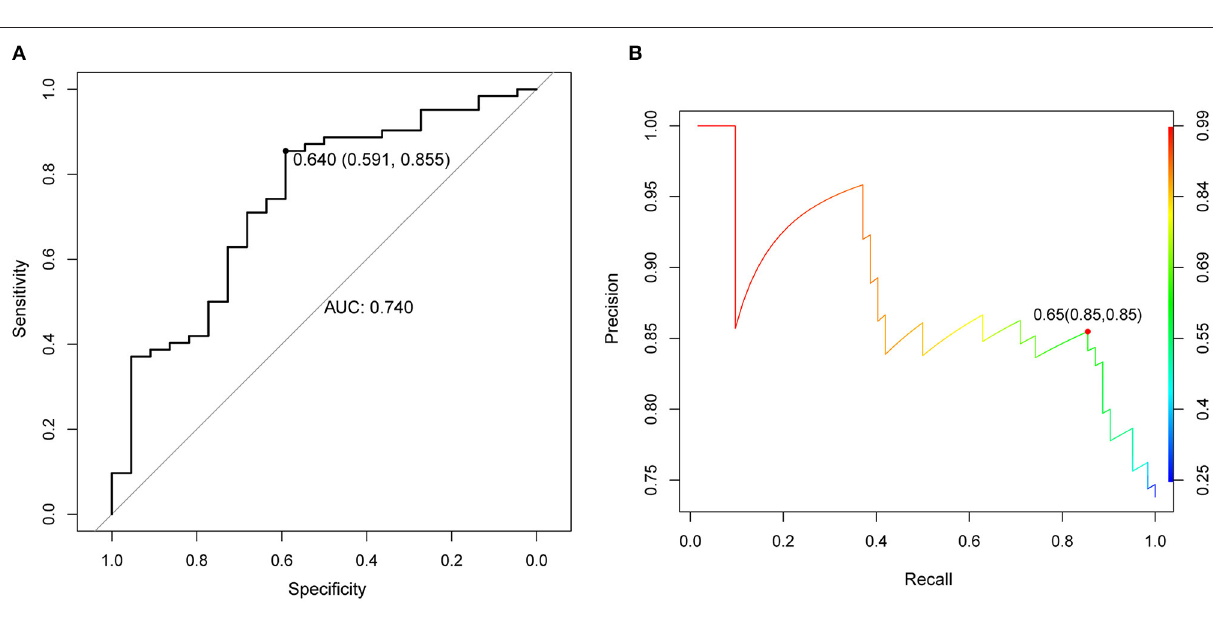
FIGURE 4 | OOB cross validation results were visualized using receiver operating characteristic curve. (A) ROC curve, the horizontal axis represented the specificity of false positive rate (FPR), and the vertical axis represented the sensitivity of true positive rate (TPR). AUC as a numerical value could directly evaluate the quality of the model, the larger the value in the range of 0 to 1, the better. (B) The diagram of OOB error. OOB: out of